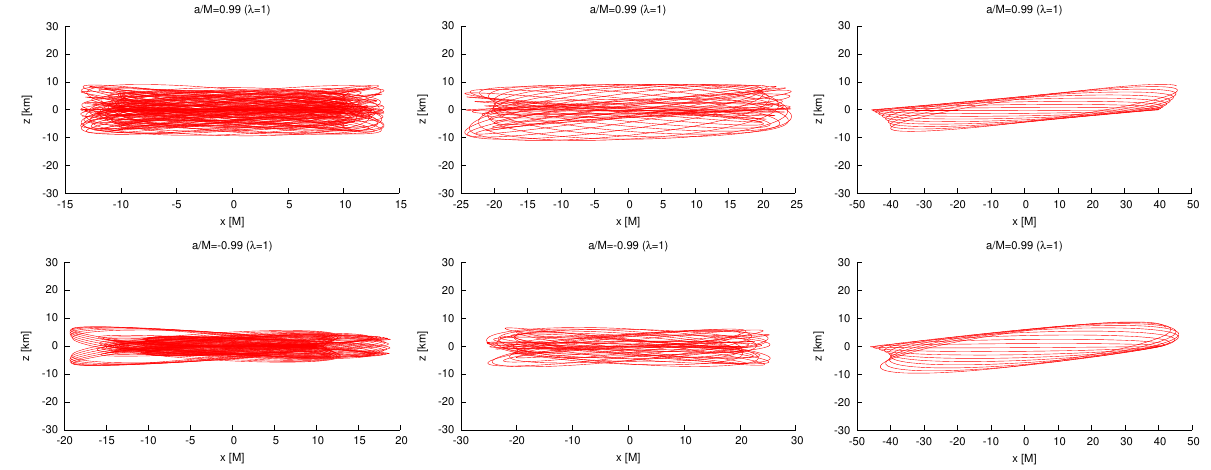
z plane for the systems in Figure 2. −